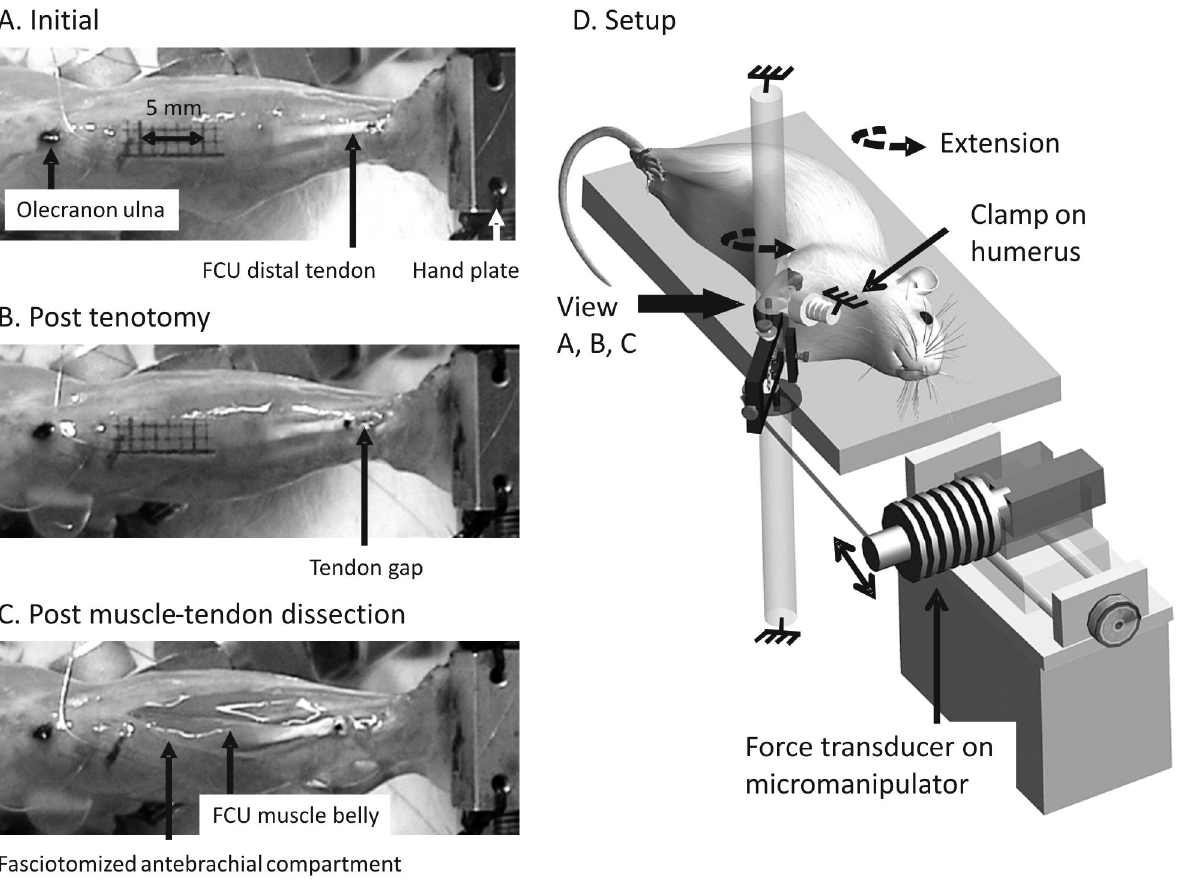
Figure 1. Schematic drawing of experimental setup and FCU imaged in various states of dissection of the right forearm. A-C. Palmar view of a right forearm mounted in the experimental setup (control animal). Measurements were performed in three